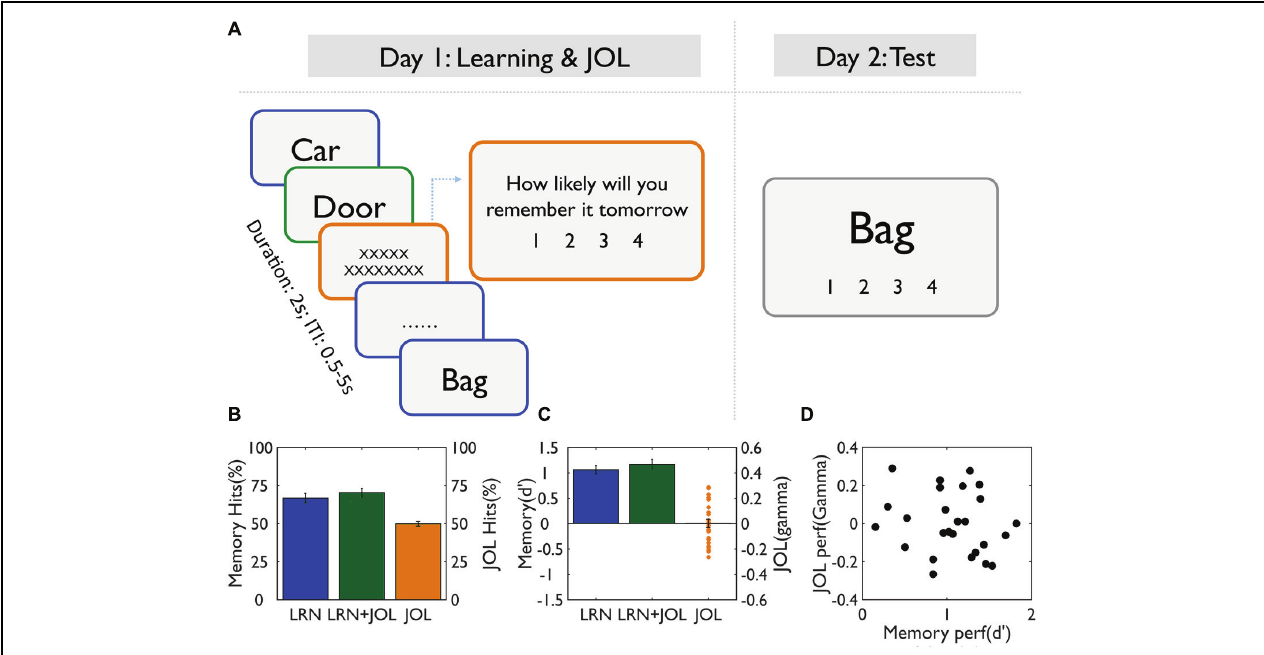
FIGURE 1 | Task procedure and behavioral results. (A) Experimental design. On Day 1, participants studied a list of words for a later memory test, using a semantic judgment task (concrete vs. abstract). For half of the trials (LRN + JOL), participants were asked to make JOL right after learning, that is, to predict how likely they would remember the items tomorrow. No JOL was performed on the other half trials (LRN) to avoid the contamination of JOL on memory performance. On Day 2, participants were asked to perform the recognition memory test on all studied trials. (B) Memory performance for the LRN and LRN + JOL trials as measured by hits rate, and JOL accuracy as measured by JOL hits (i.e., correctly predicted items). (C) Memory accuracy for the LRN and LRN + JOL trials as measured by d’, and JOL accuracy as measured by gamma. (D) The scatter plot of the relationship between memory accuracy (d’) and JOL accuracy